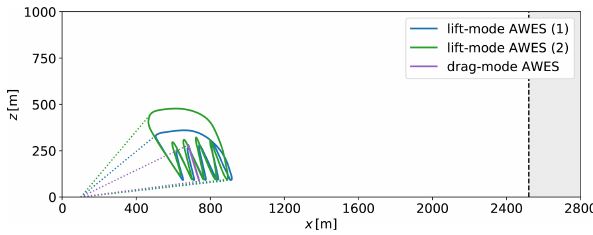
Figure A1. Side view of the computational setup of the single- system simulations used for the analysis of lift- and drag-mode AWE systems. Table A1. Resolution of the computation domain L x × L y × L z = 2800 × 1000 × 1000[m 3 ] with fine, medium, and coarse grids for the analysis of single AWE